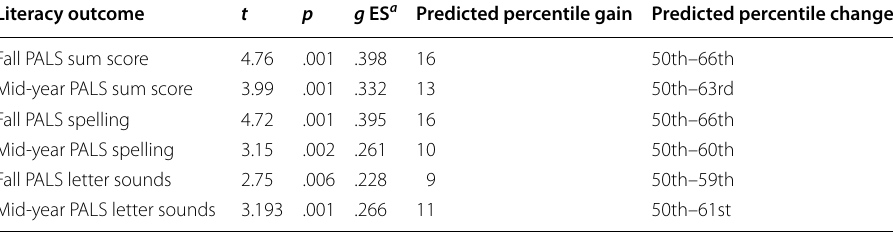
Table 3 T tests, effect sizes, and predicted percentile gains for first grade literacy out- comes as a result of Pre-K attendance